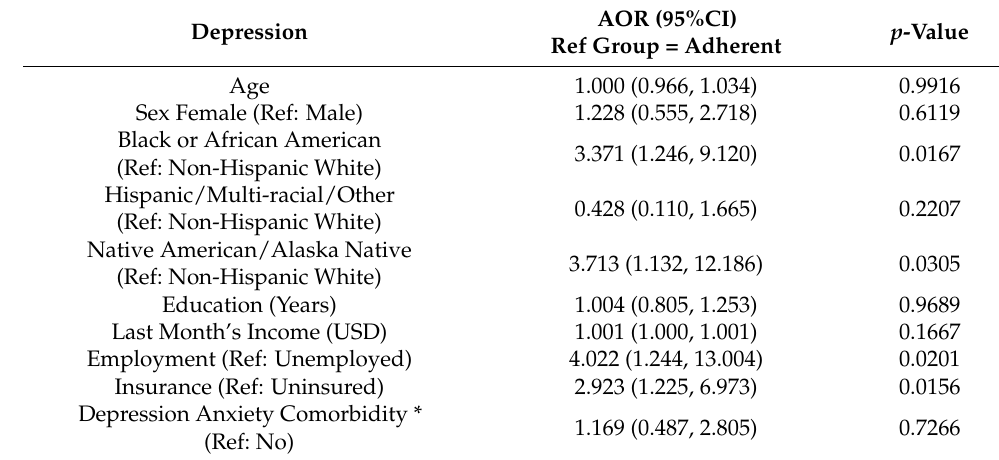
Table 2. Logistic Regression Predicting Likelihood of Reporting Medication Nonadherence—Depression.